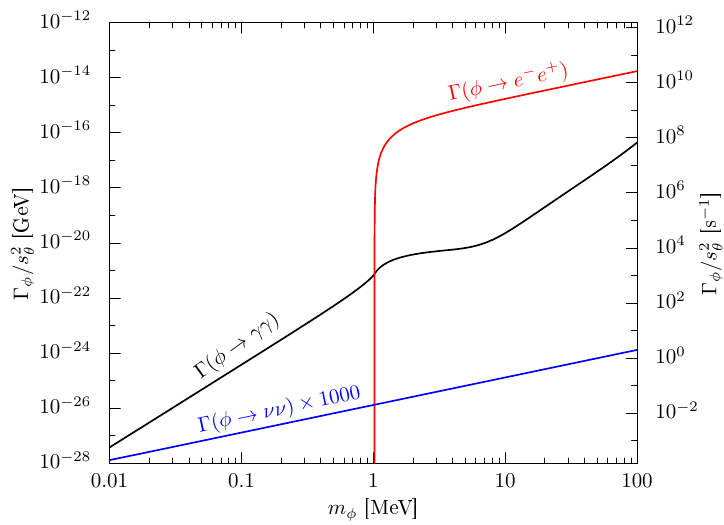
Figure 1. The decay rate of the dark scalar φ . We assume the neutrinos are Majorana fermions where the heaviest mass is 0 . 1